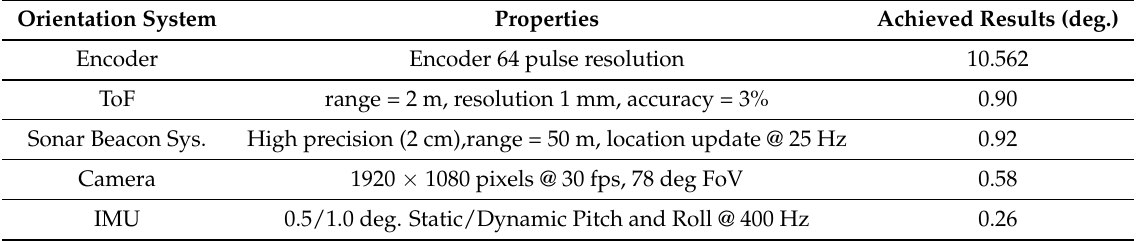
Table 3. Details of the orientation sensors and achieved results (degrees).